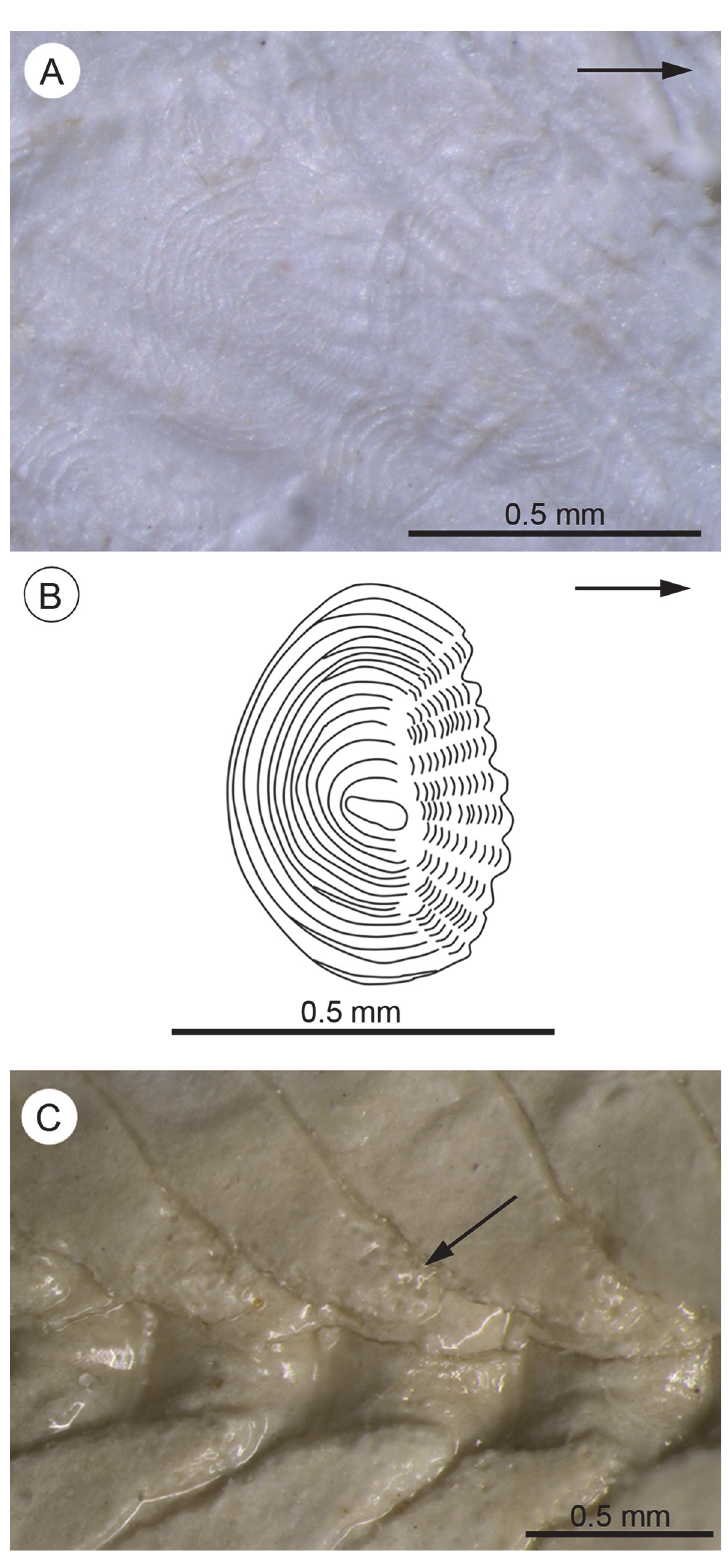
Fig 12. Details of squamation and granulation structures seen in † Kenyaichthys nov. gen. A Cycloid scales on the pectoral girdle of † Kenyaichthys cf. kipkechi (1223R´04), right lateral view (arrow